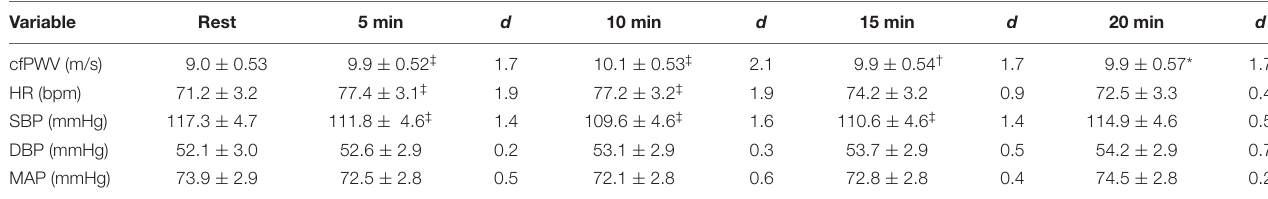
TABLE 4 | Carotid-femoral pulse wave velocity and central hemodynamics up to 20 min after acute, high-intensity aerobic exercise. Variable